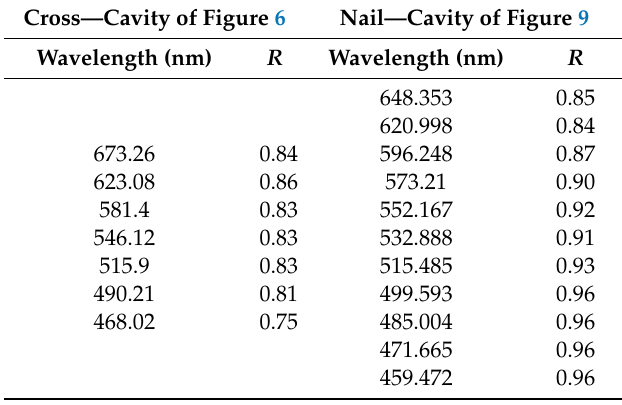
Table 2. Calculated reflectivities for both types of cavities. Cross—Cavity of Figure 6 Nail—Cavity of Figure